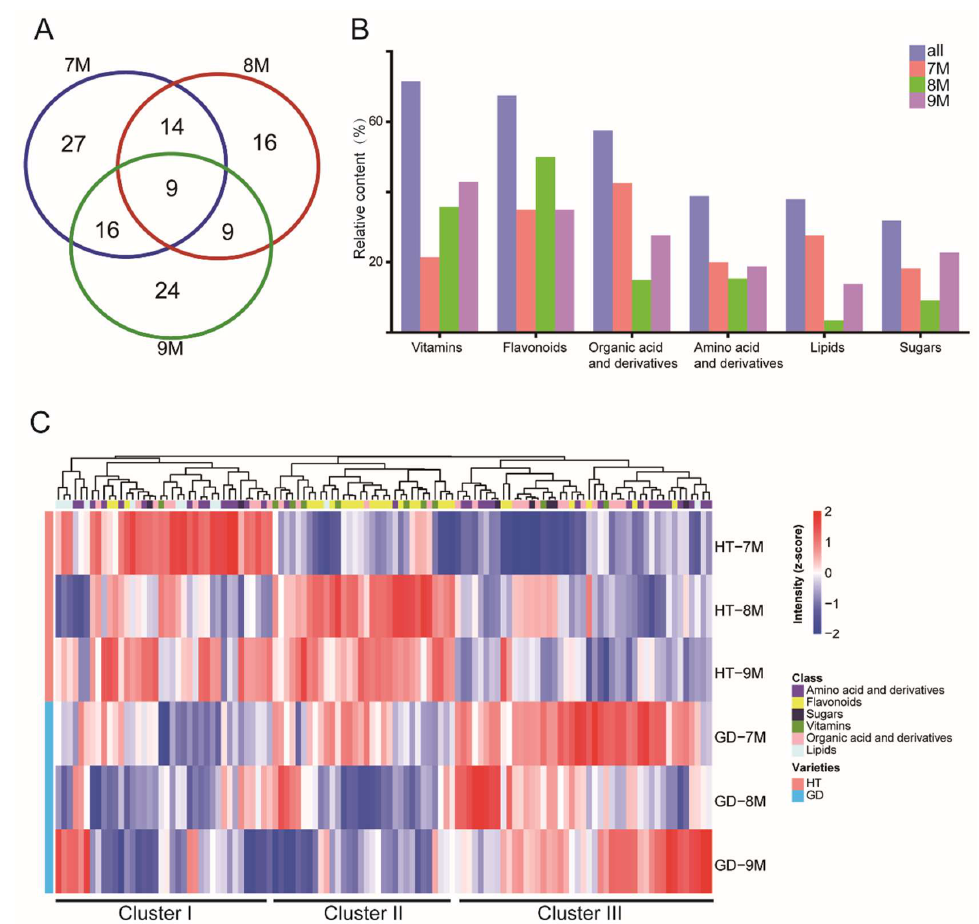
Figure 4. Differential accumulation metabolite analysis. ( A ) Venn diagram shows the number of differentially accumulated metabolites among three growth stages. ( B ) Statistical analysis of differentially accumulated metabolites in different metabolite classes. ( C ) The levels of nonvolatile of coconut flesh in two coconut varieties over three growth stages are shown the heatmaps. Hierarchical cluster analysis of differentially accumulated metabolites. Each column in the figure represents a metabolite, each row represents either GD or HT coconut varieties at three different growth